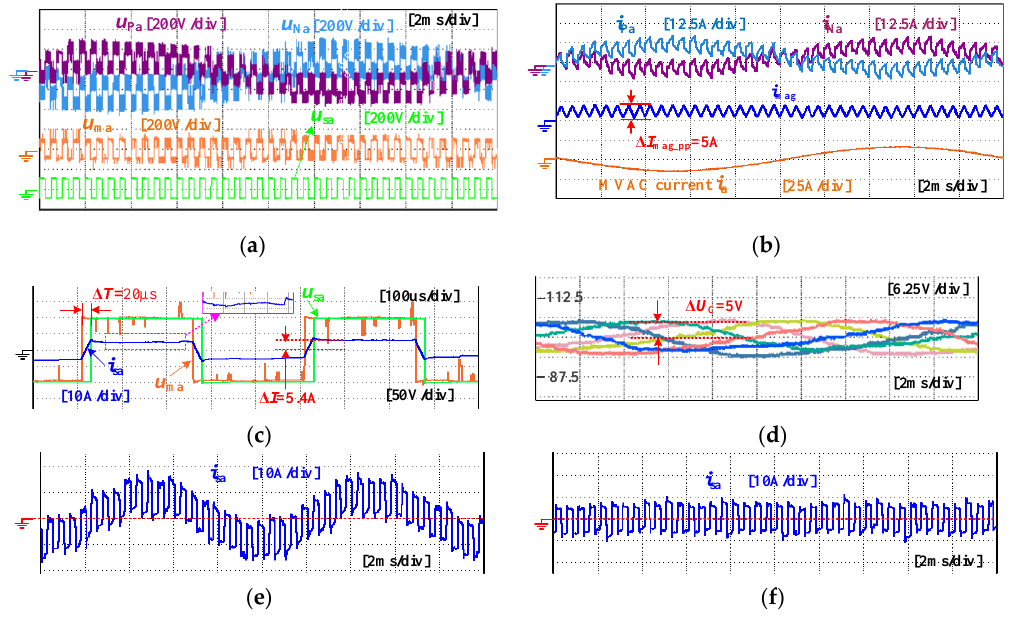
Figure 10. Experiment results: ( a ) arm voltages and transformer winding voltages; ( b ) arm currents, magnetizing current and MVAC current; ( c ) transformer winding voltages and secondary winding current; ( d ) six arm SM voltages; ( e ) secondary winding current with double LF fluctuation; ( f ) secondary winding HF current after applying the proposed modulation.